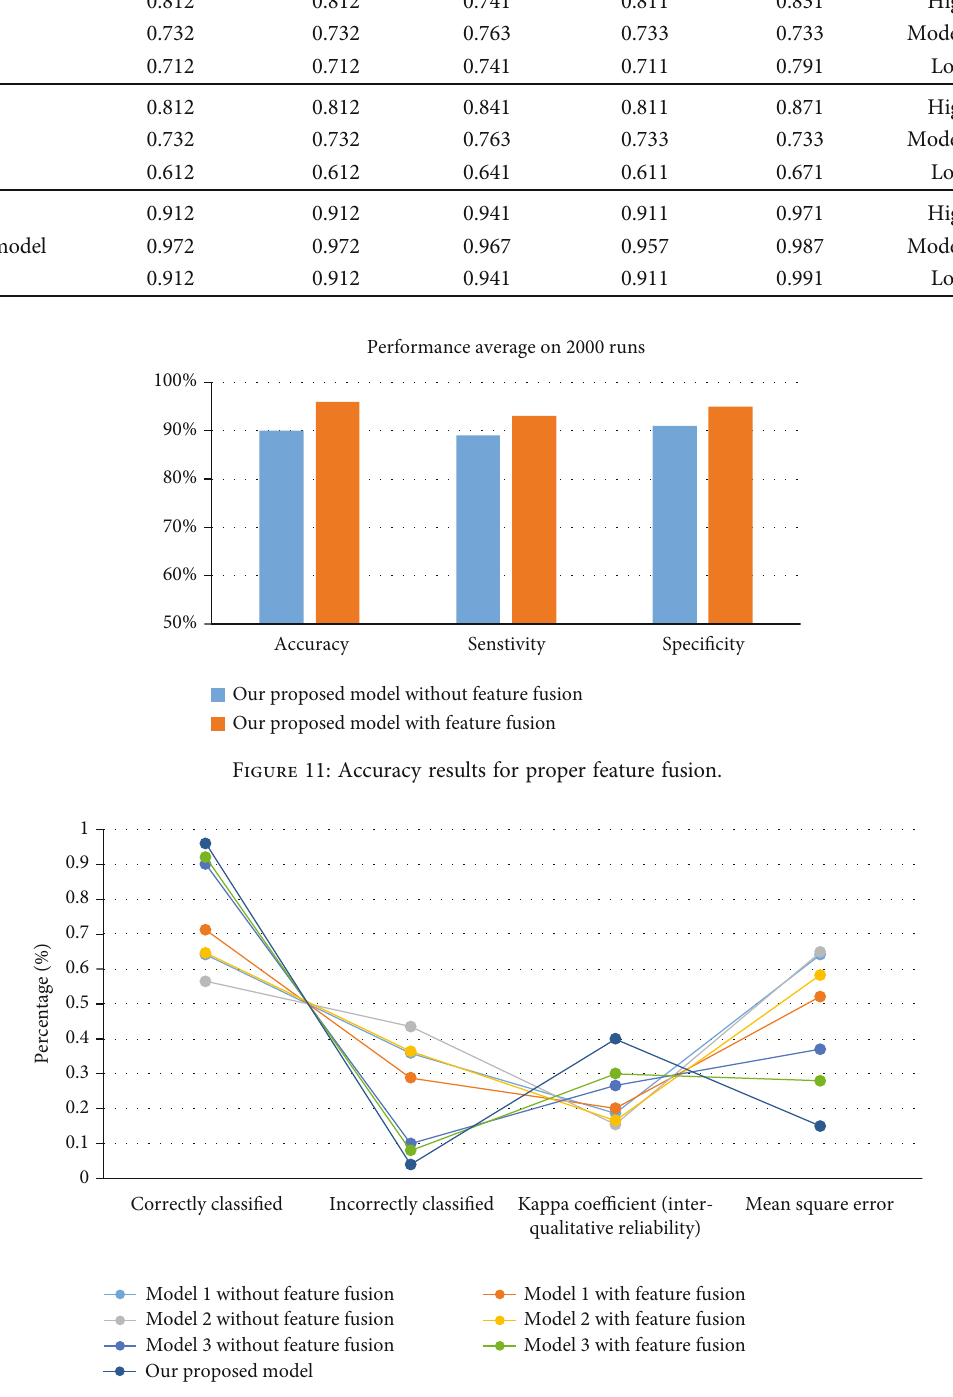
Figure 12: Correctly classi fi ed versus incorrectly classi fi ed case comparison for di ff erent models with and without feature